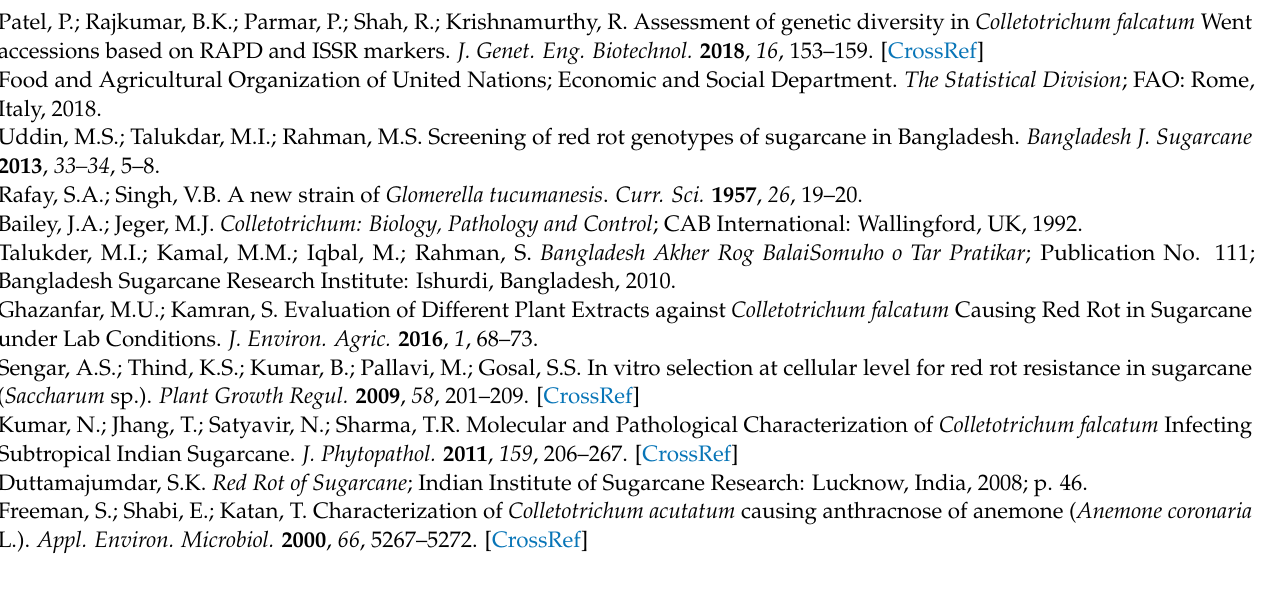
and their accession numbers, Supplementary Figure S2. Phylogenetic tree of C. falcatum isolates using Maximum likelihood method based on (a) ITS and (b) β -tubulin sequences. The tree was rooted with Monilochaetes infuscan.ML bootstrap value is indicated at each node, Supplementary Figure S3. Phylogenetic tree of C. falcatum isolates using Maximum Likelihood method based on (a) Actin and (b) GAPDH sequences. The tree was rooted with Monilochaetes infuscan.ML bootstrap value is indicated at each